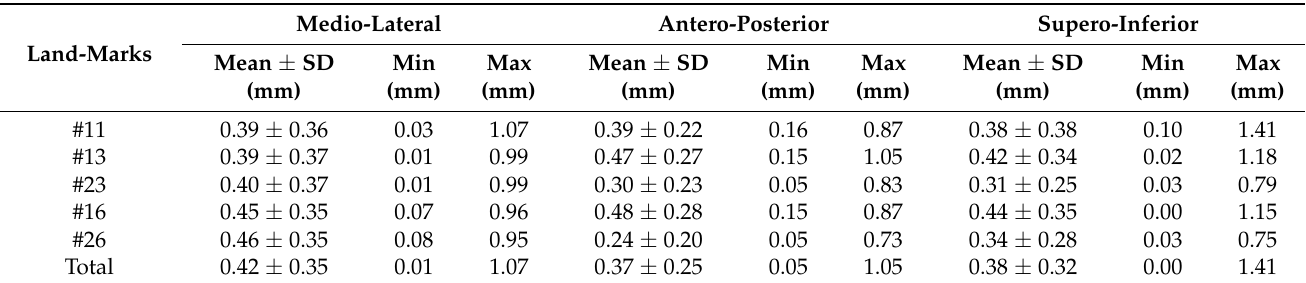
Table 4. Mean absolute deviation between the planned and actual postoperative maxillary positions.